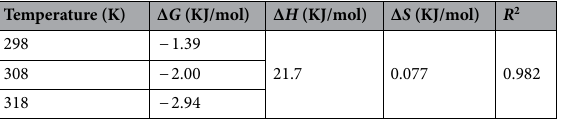
Table 6. Thermodynamic values of Cu 2+ ion biosorption onto R. damascena .